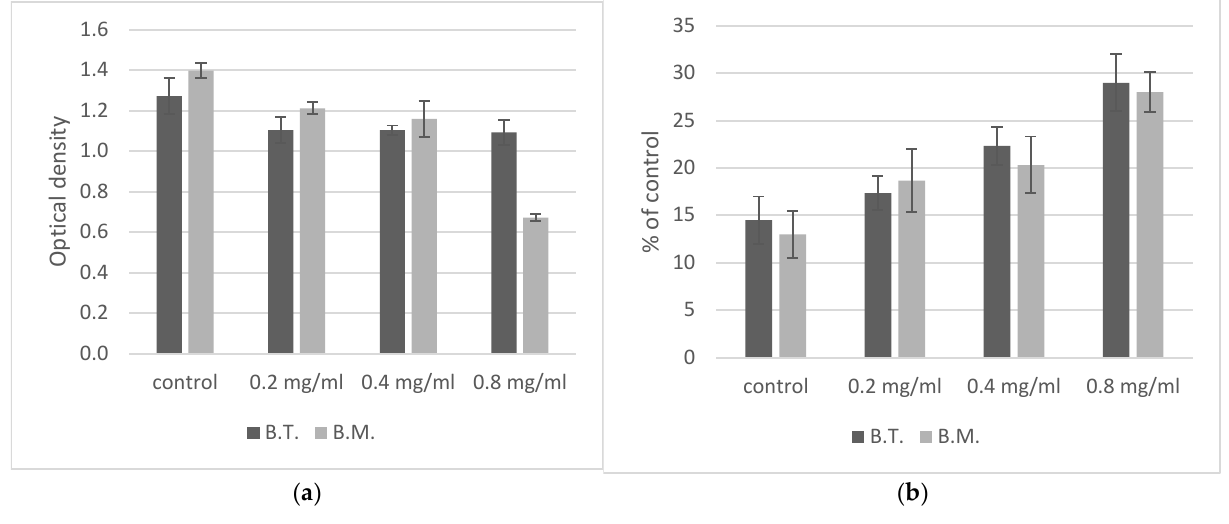
Figure 1. Concentration-dependent inhibition of Bacillus sp. planktonic cell growth by ZnO NPs. ( a ) Effects of zinc oxide nanoparticles on values of OD at 600 nm. Statistical tests confirmed that the concentration of ZnO NPs influences the OD value, but the type of strain does not affect the OD value of a culture treated with ZnO NPs. ( b ) Influence of nanoparticles on cell’s sporulation. The concentration of ZnO NPs statistically significantly affects the number of spores produced, but no statistically significant differences were shown between strains of bacteria. B.T. — Bacillus thuringiensis , B.M. — Bacillus megaterium . Table 1. Pearson correlation coefficients and ANOVA showing the effect of ZnO NPs on selected parameters of the growth and metabolic activity of Bacillus spp. strains.